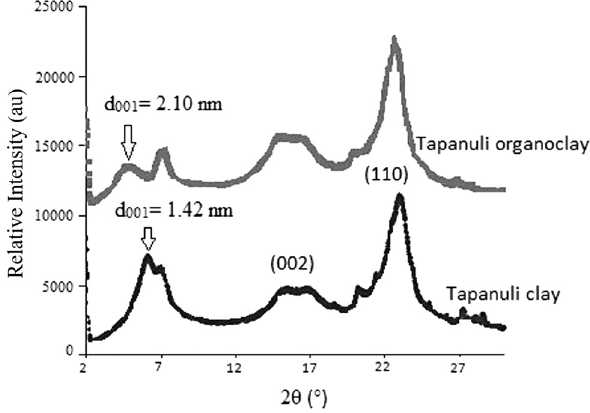
Figure 6: Low - angle XRD pattern of organoclay. Reproduced from ref. [ 92 ] with